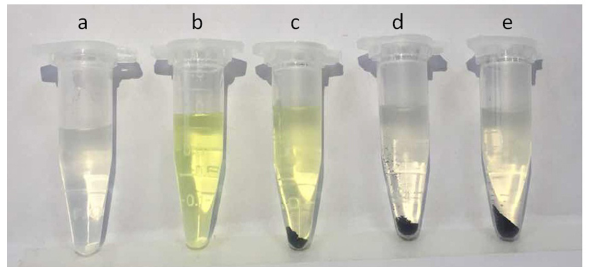
Figure 4. Optical photographs of the hydrolysis of p ‐ NPC8 catalyzed by different samples: ( a ) control; ( b ) free lipase QLM; ( c ) immobilized enzyme; ( d ) polydopamine ‐ coated Fe 3 O 4 nanoparticles and ( e ) Fe 3 O 4 nanoparticles.